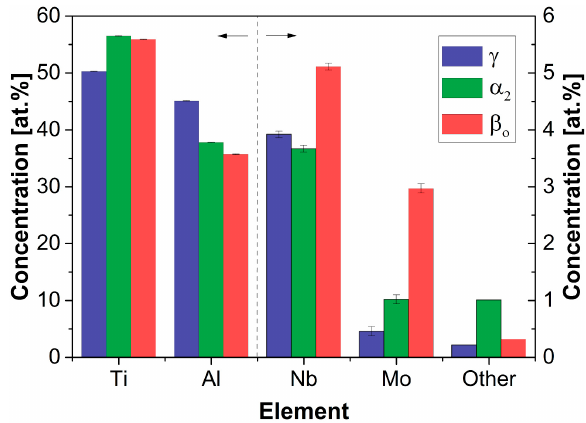
Figure 5. Phase composition of a TNM alloy in the homogenized condition. Concentrations of the major alloying elements, Ti and Al, are displayed on the left ordinate, whereas concentrations of the minor alloying elements, Nb, Mo as well as impurities denoted as “Other” are given on the right ordinate. Titanium shows a slightly higher concentration in α 2 and β o than in the γ phase and at the same time the Al concentration is reduced. This enormous difference in phase composition in comparison to the ideal binary phases (Ti 3 Al and TiAl, respectively) is due to preferred lattice site occupation of transition metal atoms on Ti sites in the α 2 phase and Al sites in the β o phase. Nb and Mo both show a tendency to accumulate in the β o phase corresponding to their well-established β -stabilizing effect, which is more pronounced in case of Mo. Impurities, mainly constituted by interstitial elements like C, N or O (here their sum is referred to as “Other”), prefer to locate in the α 2 phase.